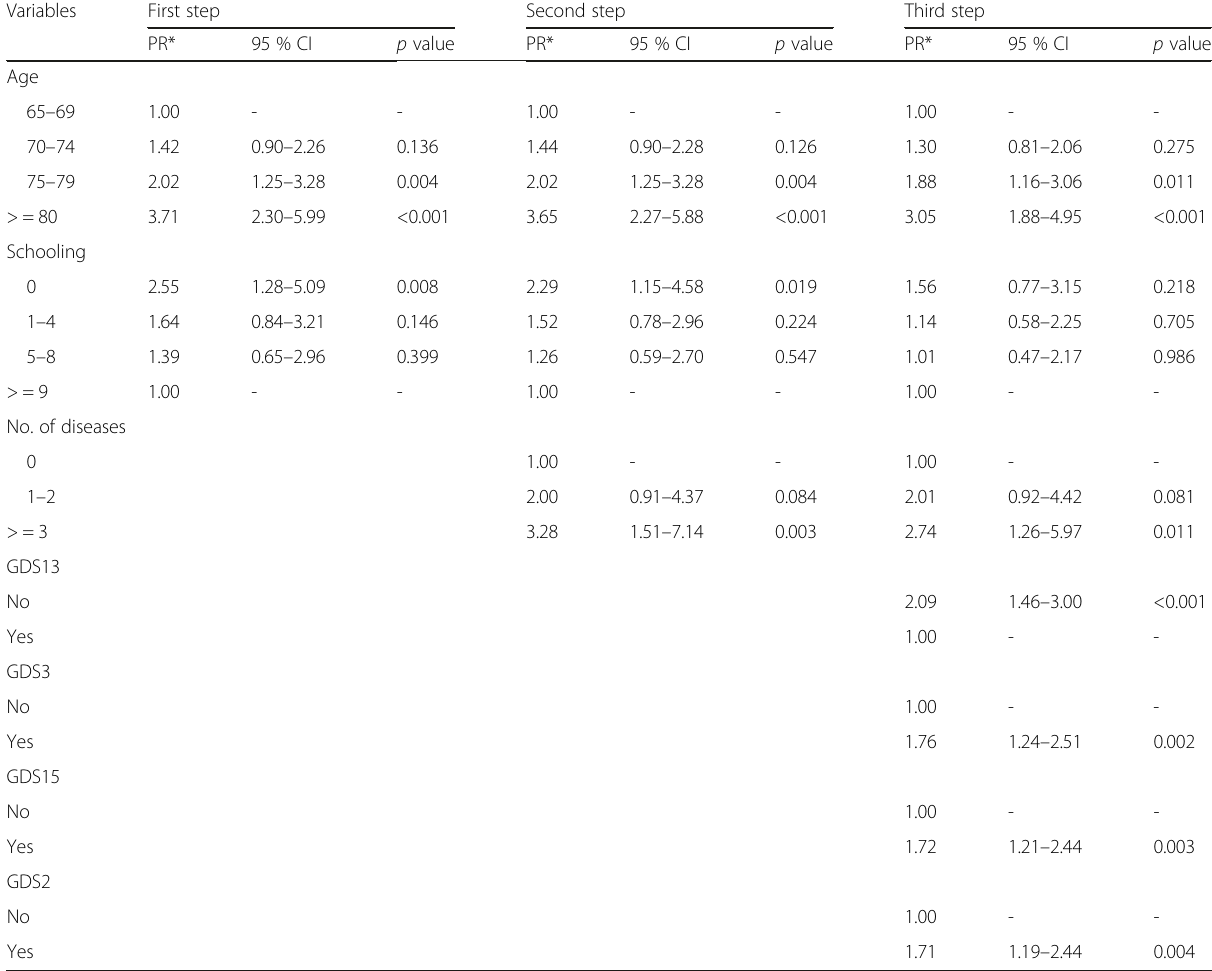
Table 6 Hierarchical model with multivariate Poisson regression for frailty ( n = 1030). FIBRA Unicamp, Elderly, 2008 – 2009